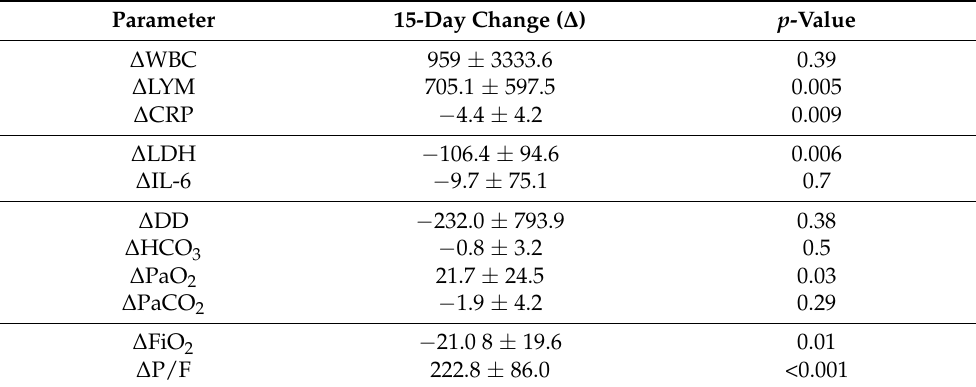
Table 2. Average change in selected clinical and serological parameters over